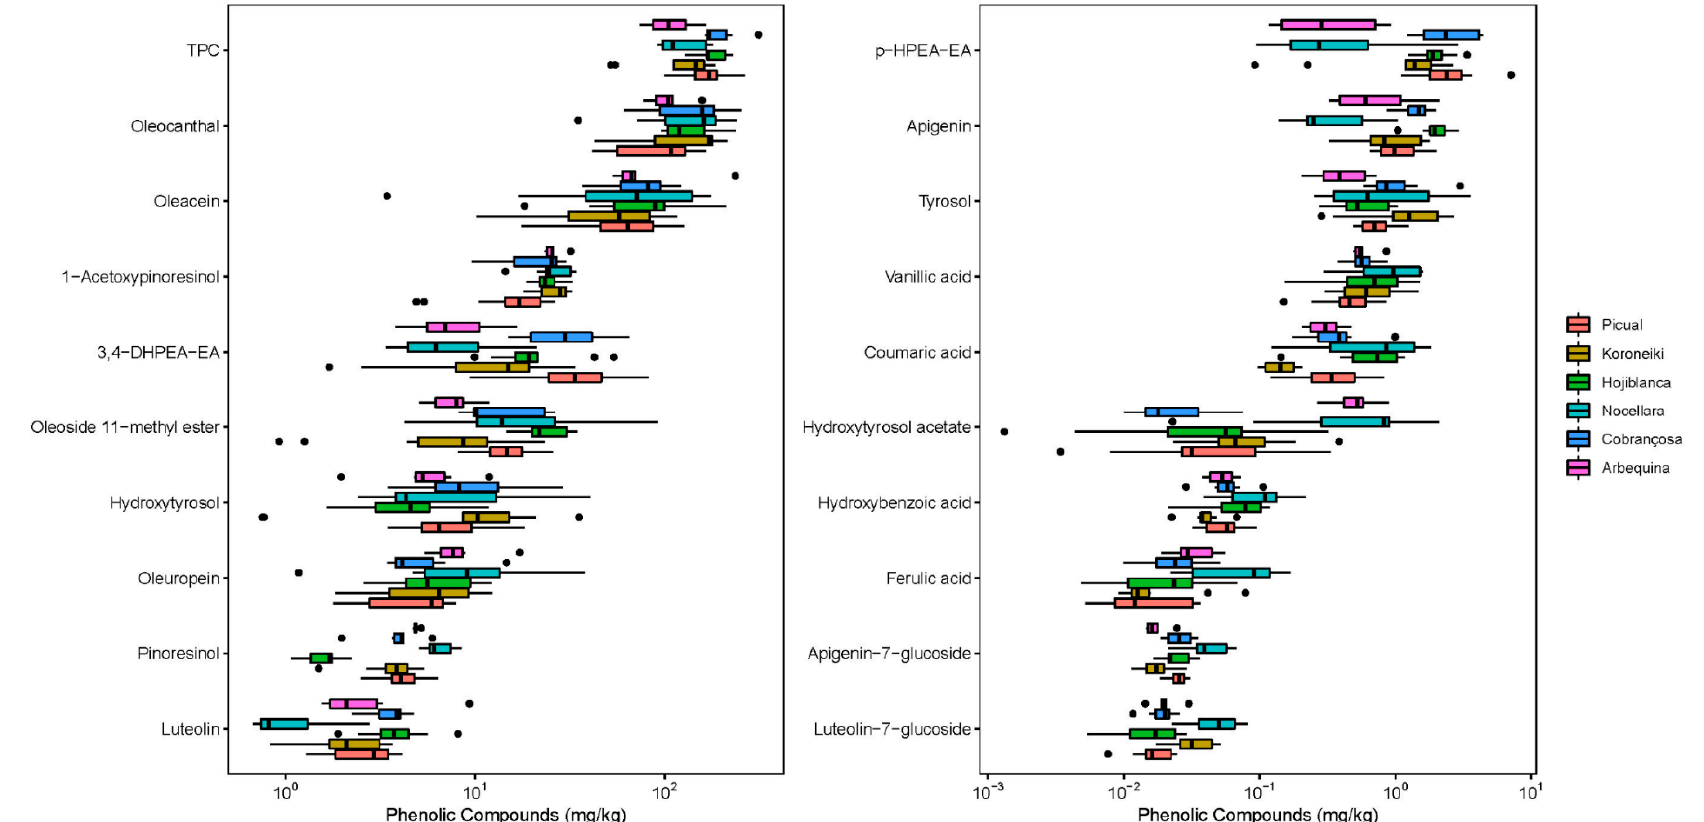
Figure 1 . Individual phenolic compounds of oil from six olive varieties. Figure 1. Individual phenolic compounds of oil from six olive